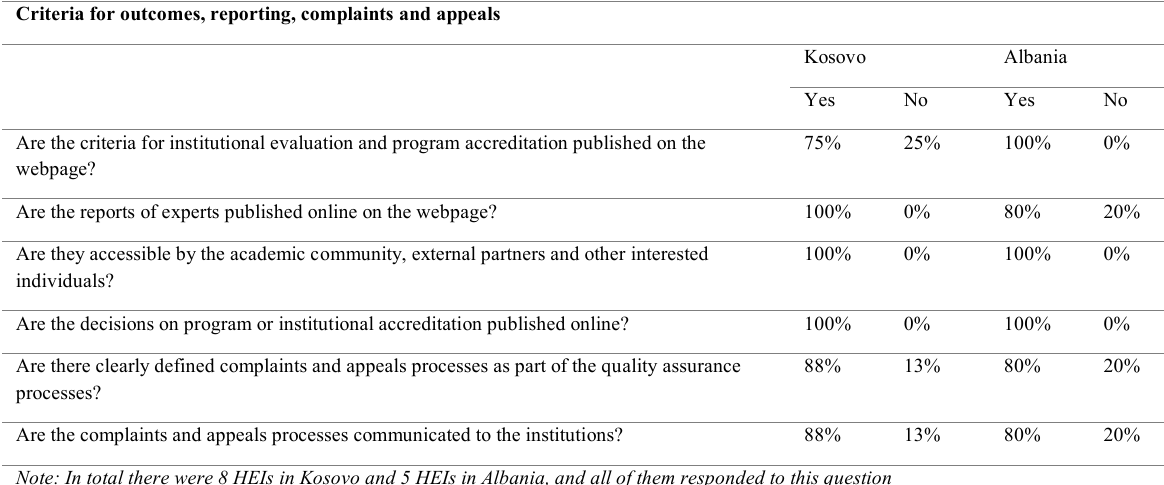
Table 10 : External quality assurance: Criteria for outcomes, reporting, complaints and